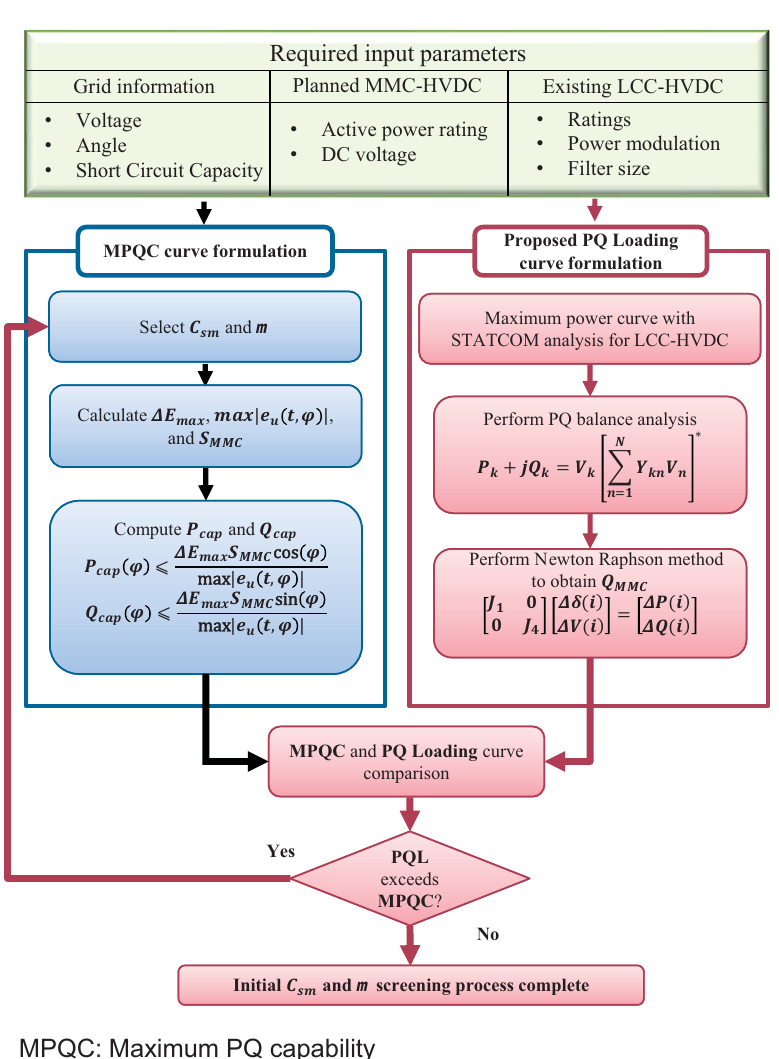
Figure 2. Generic analysis framework for estimating submodule capacitance and modulation index of MMC-HVDC in